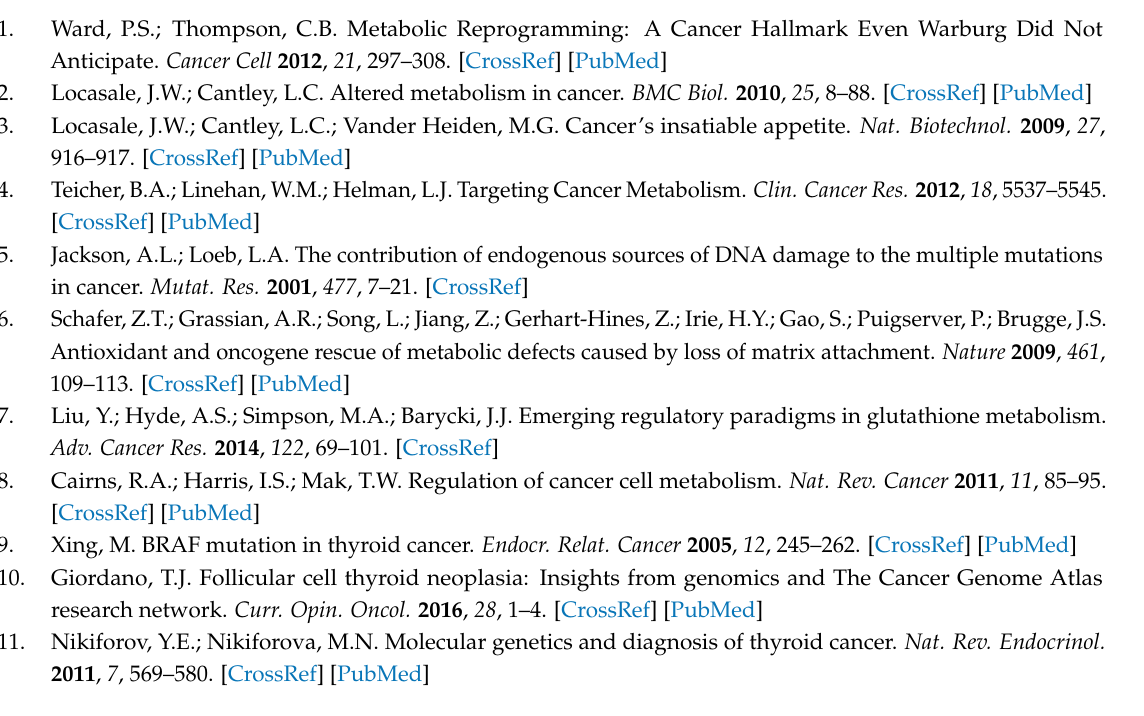
Figure S1: Nucleotides levels in PTC-derived cells. Figure S2: Amino acids levels in PTC-derived cells. Table S1: Holm-Bonferroni sequential correction of p values obtained from unpaired Student t